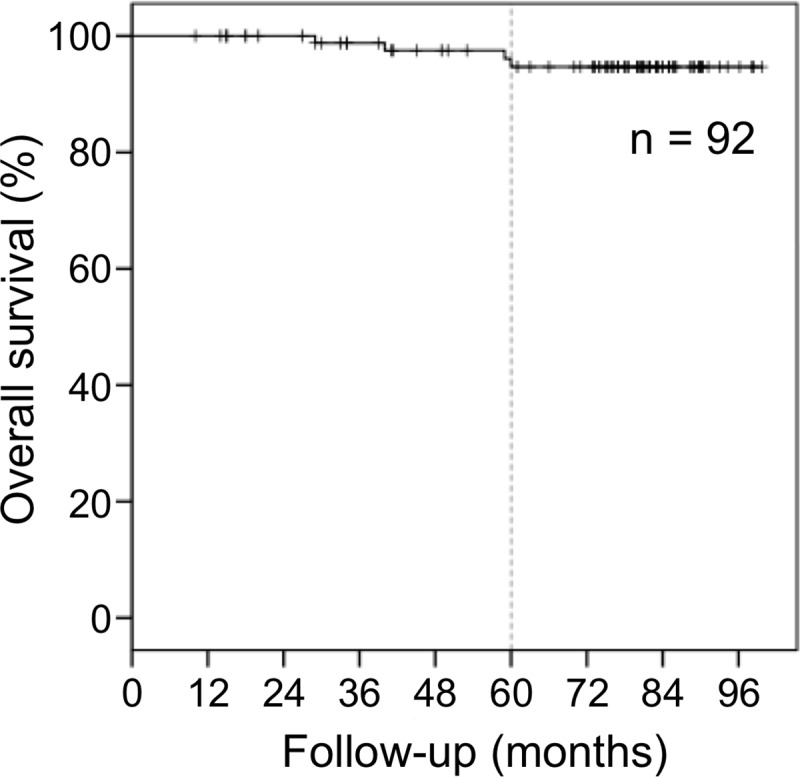
Overall survival.The overall survival rate at 5 years was 94.7%.